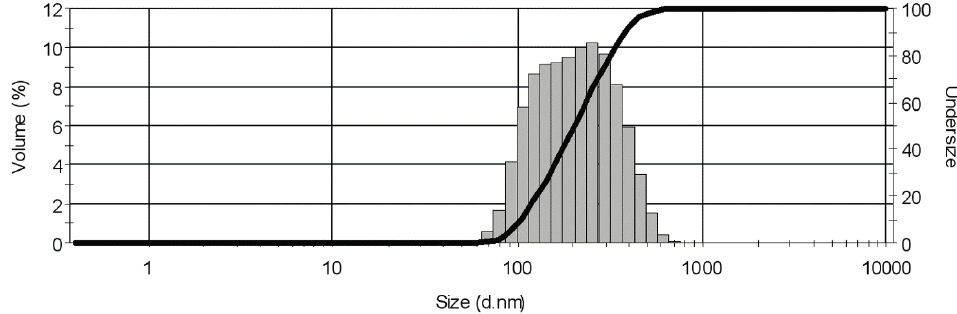
Figure 4. PSD of CuO particles (Table 1, sample